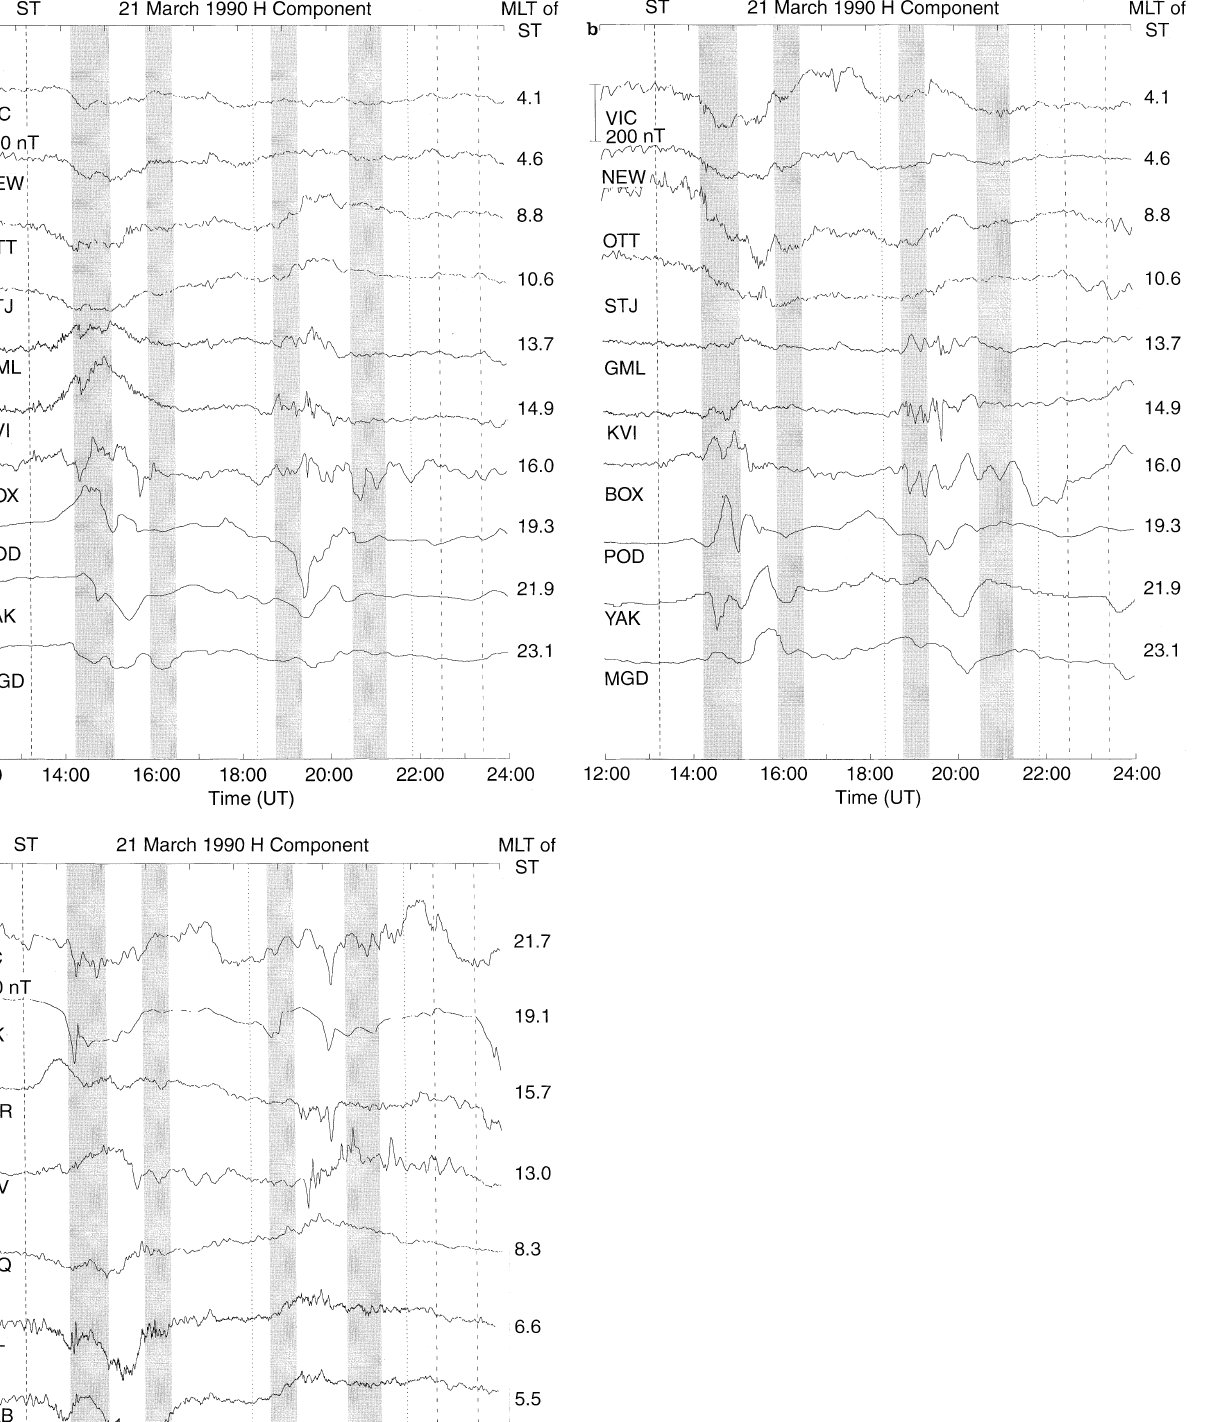
Fig. 6a–c. As for Fig. 5 except presenting the magnetic variation for interval 2: 1200 UT to 2400 UT March 21, including the 1314 ((cid:139)5) UT southward turning (ST) at the magnetopause (- - - - -) for a H and b D components for the 55 (cid:176) N chain and c H component for the 67 (cid:176) N chain. The magnetic local time is stated for each station at the time of the southward